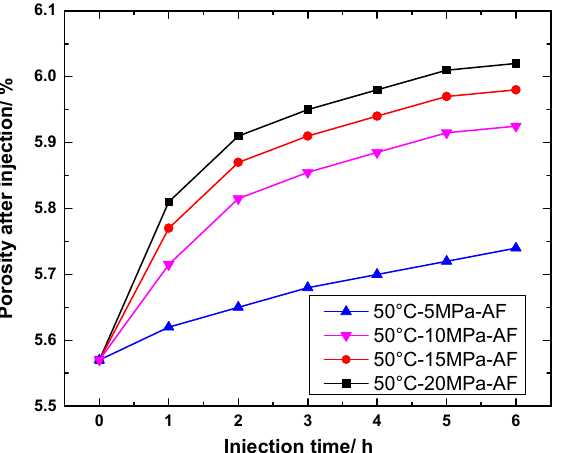
Figure 11. Variation in porosity with time for AF specimens under different pressures.